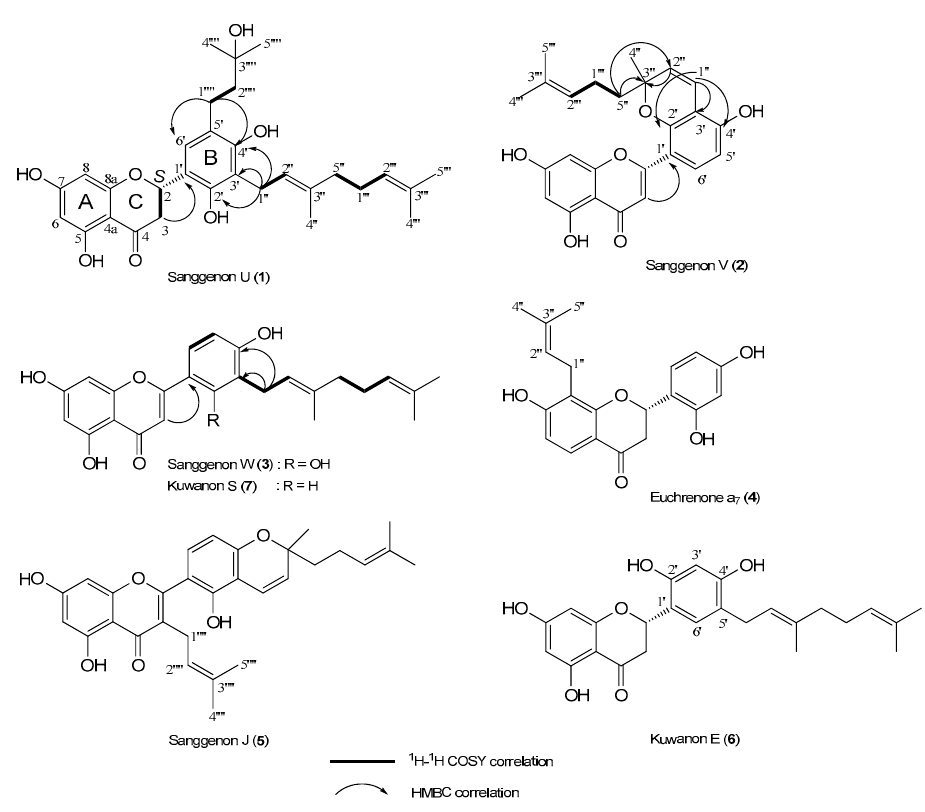
Figure 2. Chemical structures of compounds 1 – 7 from the root bark of Morus alba and key 1 H- 1 H COSY and HMBC correlations for compounds 1 – 3 .